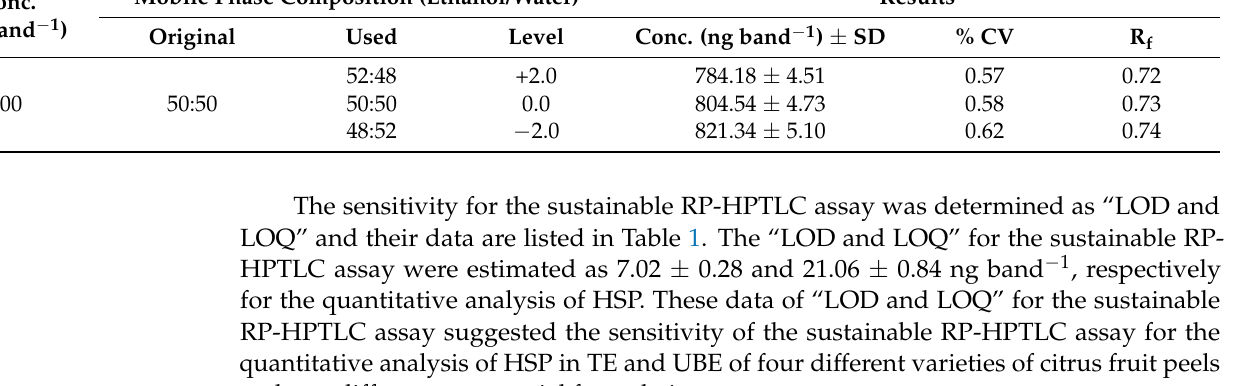
Table 5. Results of robustness evaluation for HSP for a sustainable RP-HPTLC assay (mean ± SD; n = 6).